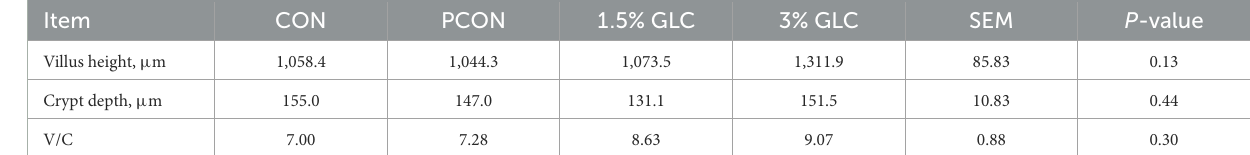
TABLE 5 Effects of dietary Ganoderma lingzhi culture (GLC) supplementation on the ileum morphology of Sanhuang broilers on day 56.